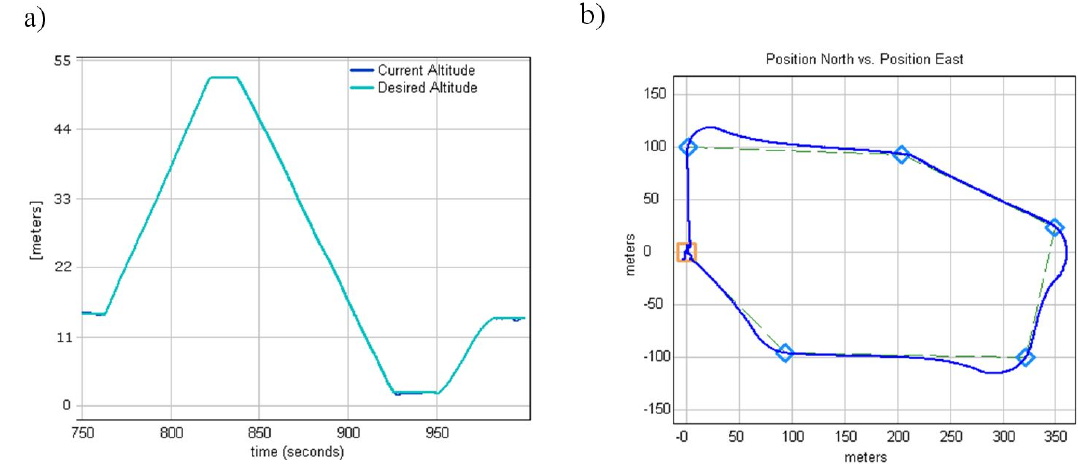
Figure 10. ( a ) Altitude loop performance. ( b ) Flight trajectory through waypoints.